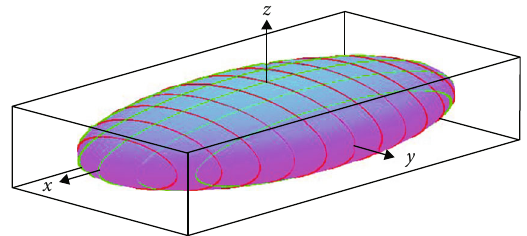
Figure 4: Schematic diagram of a continuous fracture